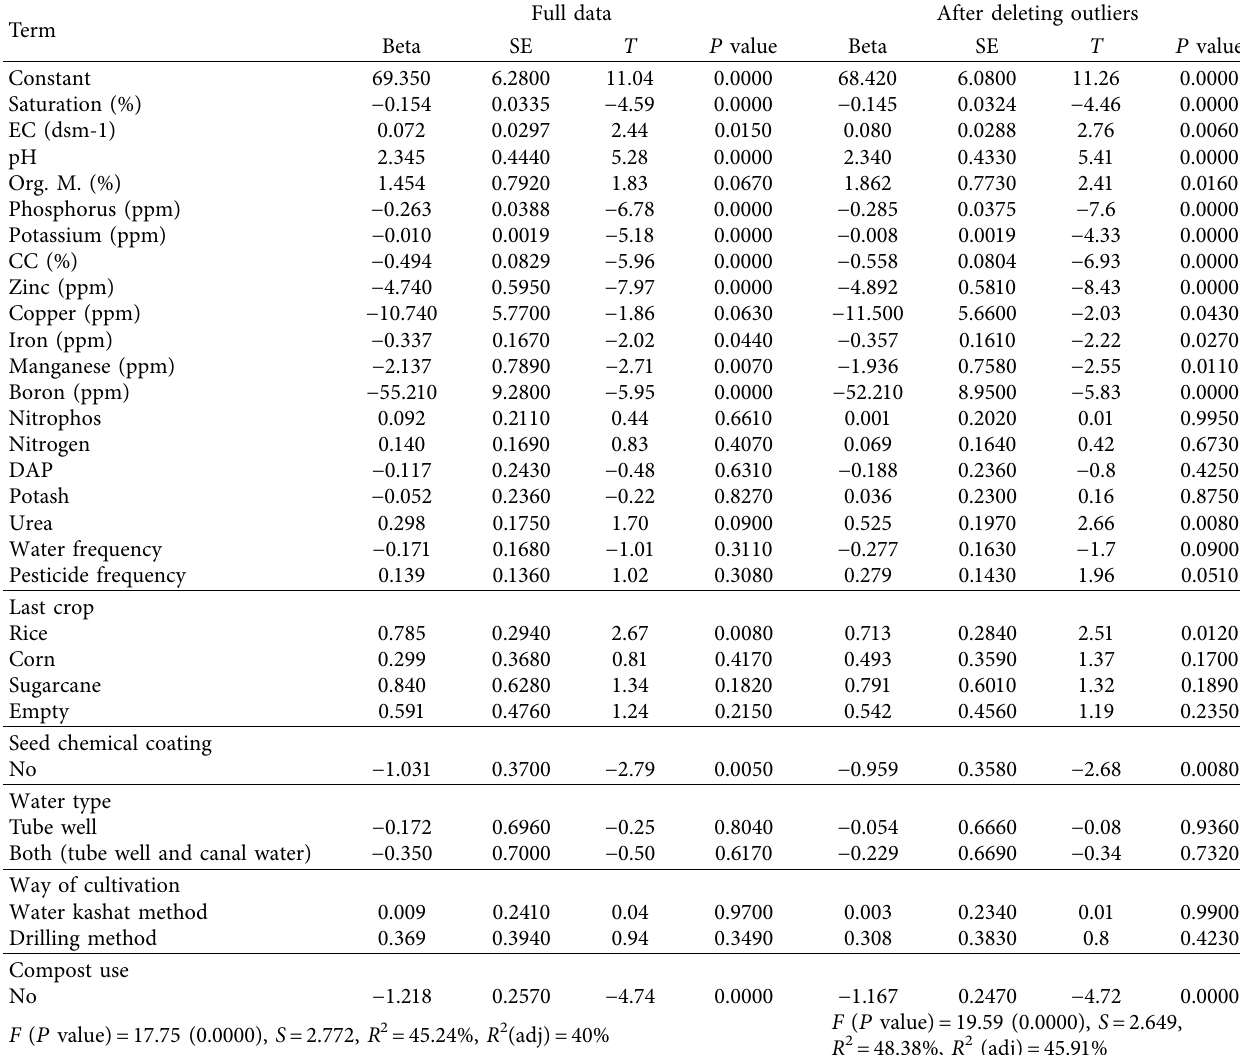
Table 4: Regression analysis with and without